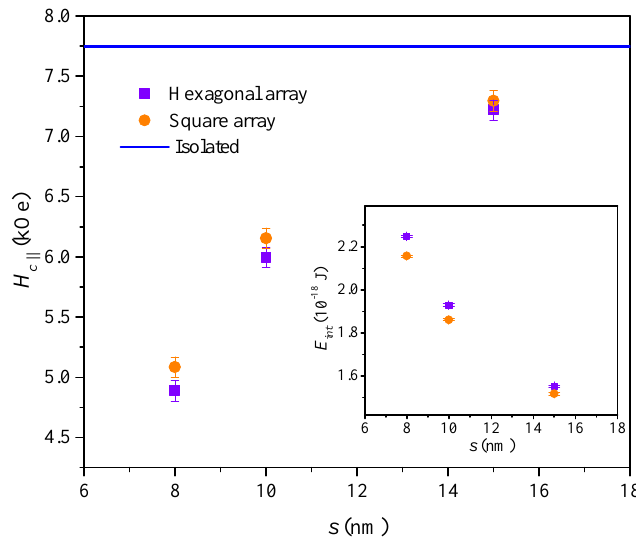
Figure 7. The dependence of coercive field for square and hexagonal arrays of Fe cylindrical nanos- tructures on the distance between them. The dash horizontal line represents the coercive field value for an isolated cylinder. The inset shows the dependence of magnetostatic interaction energy on the distance between nanostructures in square and hexagonal